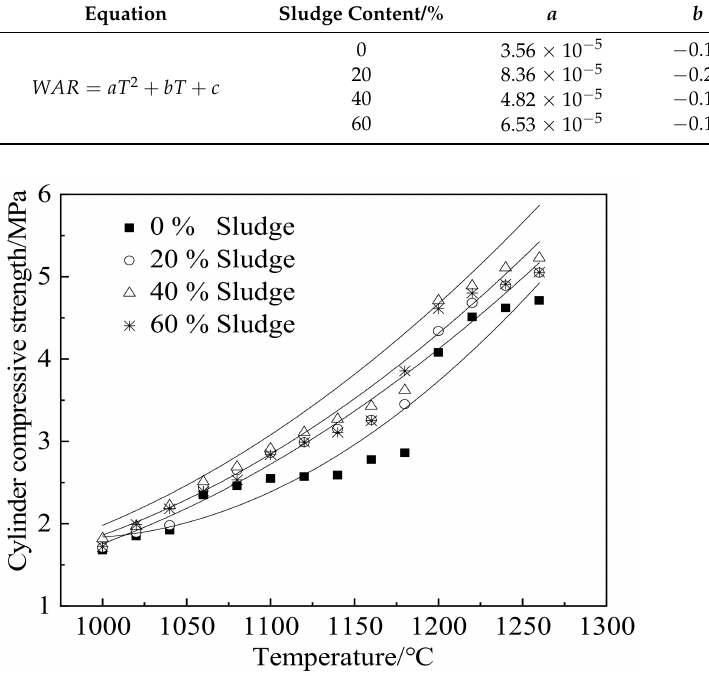
Figure 4. Cylinder compressive strength of ceramsite containing different contents of